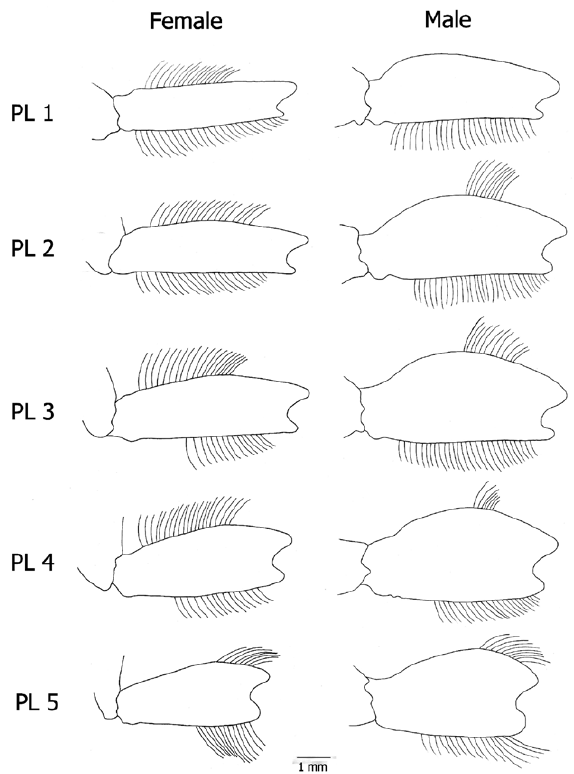
Fig. 2. – Lateral view of the protopods of each five right pleopods (PL) of a Pasiphaea sivado female with 22.7 mm CL and of a male with 22.6 mm CL.